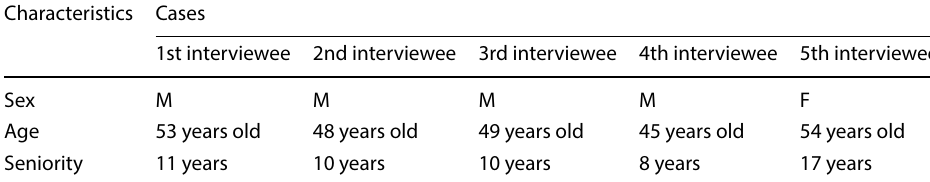
Table 1 Characteristics of